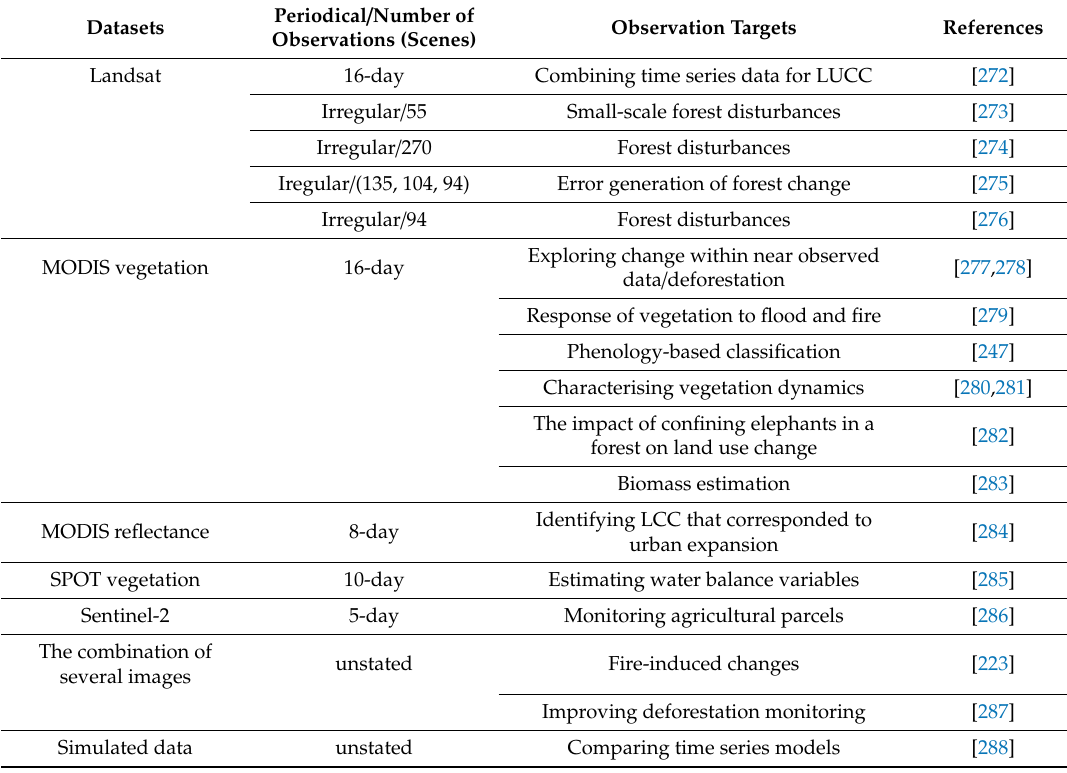
Table 5. Varying image revisit times and observation targets implementing